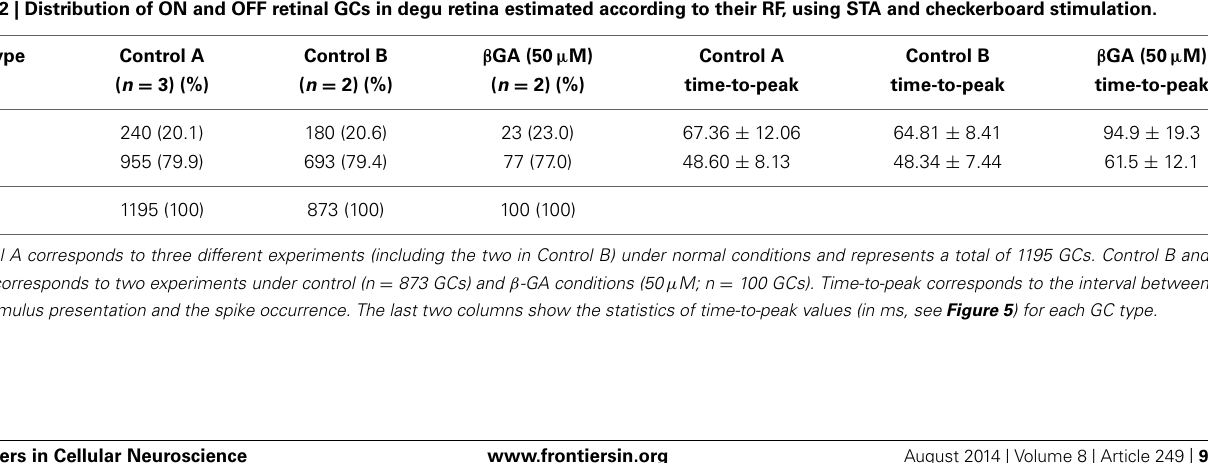
Table 2 | Distribution of ON and OFF retinal GCs in degu retina estimated according to their RF, using STA and checkerboard stimulation. Cell type